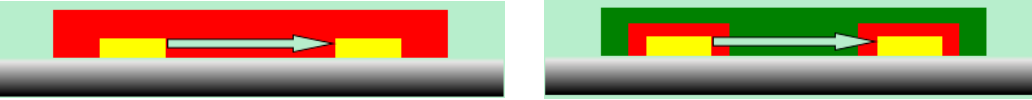
Figure 2. Schematic view of a PPy/s-CoPc resistor ( left ) compared to a PTFA/LuPc2/PTFA double lateral heterojunction ( right ); the arrows indicate the main channel for charge